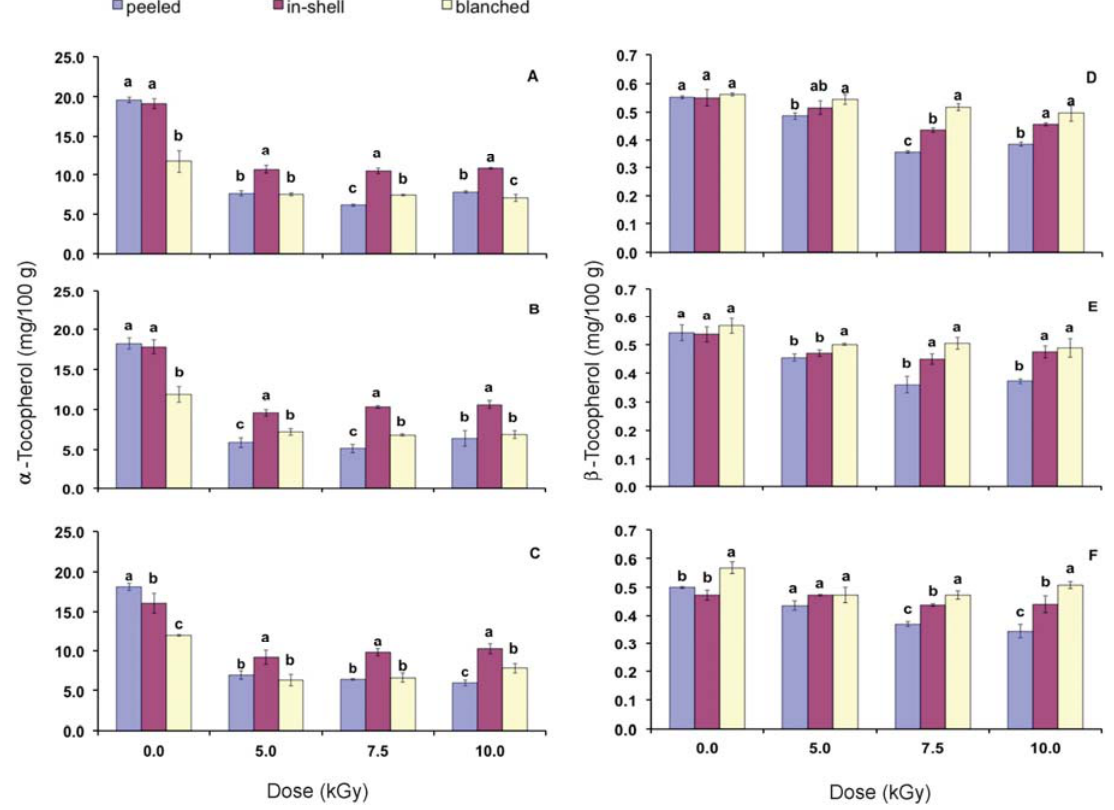
Figure 1. α -Tocopherol content on time zero ( A ), in the third ( B ) and sixth month storage ( C ). β -Tocopherol content on time zero ( D ), in the third ( E ) and in the sixth month storage ( F ). Error bars represent standard deviations of triplicate measurements. Means with the same letter within a gamma radiation dose are not statistically different by Tukey’s multiple test ( p <